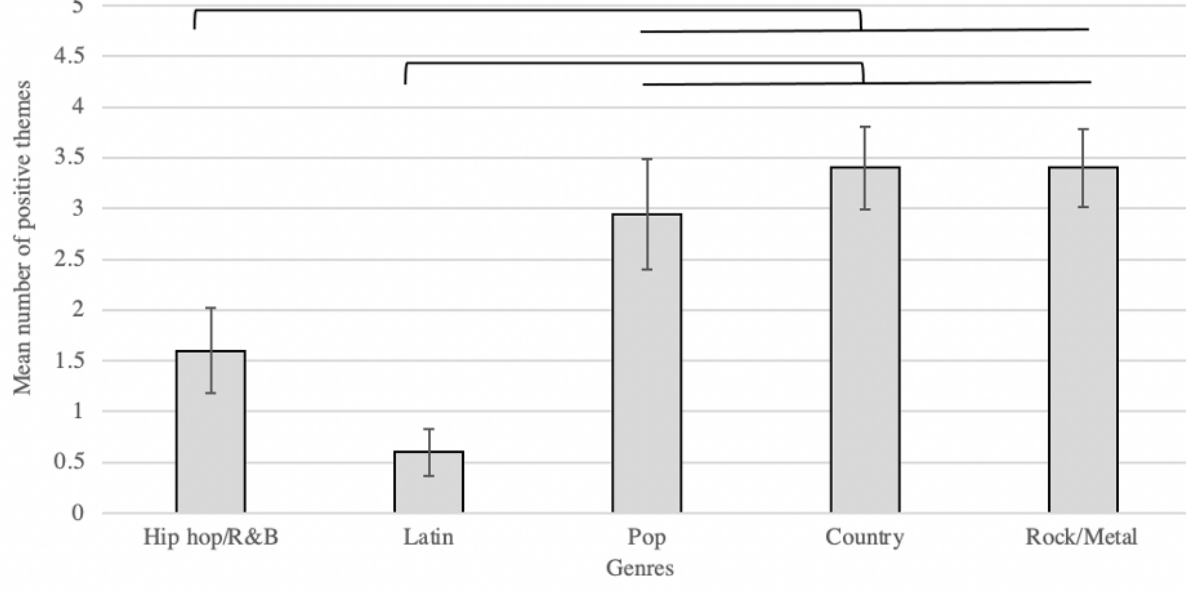
Figure 2. Mean number of positive themes in each genre from 1998 to 2018. Error bars reflect SE. Results show hip hop/R&B had a significantly lower number of positive themes in lyrics when compared to pop ( P =.03), country ( P =.003), and rock/metal ( P =.002). Additionally, Latin music was also significantly different from pop, country, and rock/metal (all P values <.001). R&B: rhythm and